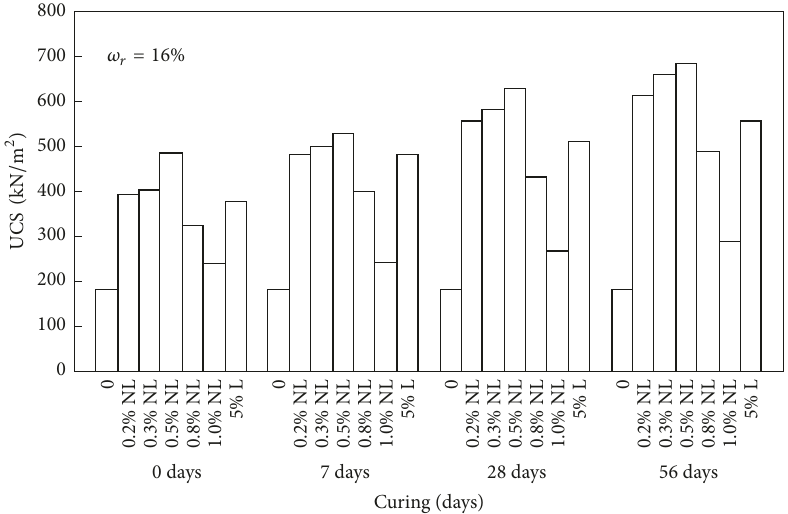
Figure 5: UCS development over curing periods for original soil, soil-nanolime mixtures, and soil-lime mixture at remolded water content of